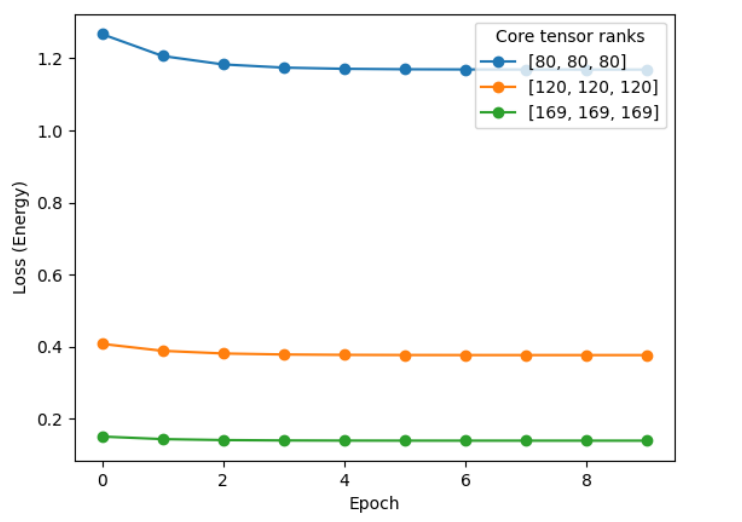
Figure 11. Gated RBM energy loss comparison with different core tensor ranks.